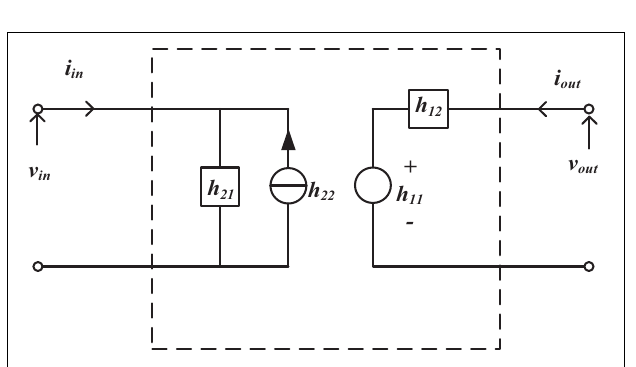
FIGURE 5 | Small signal two-port equivalent circuits of rectifier.